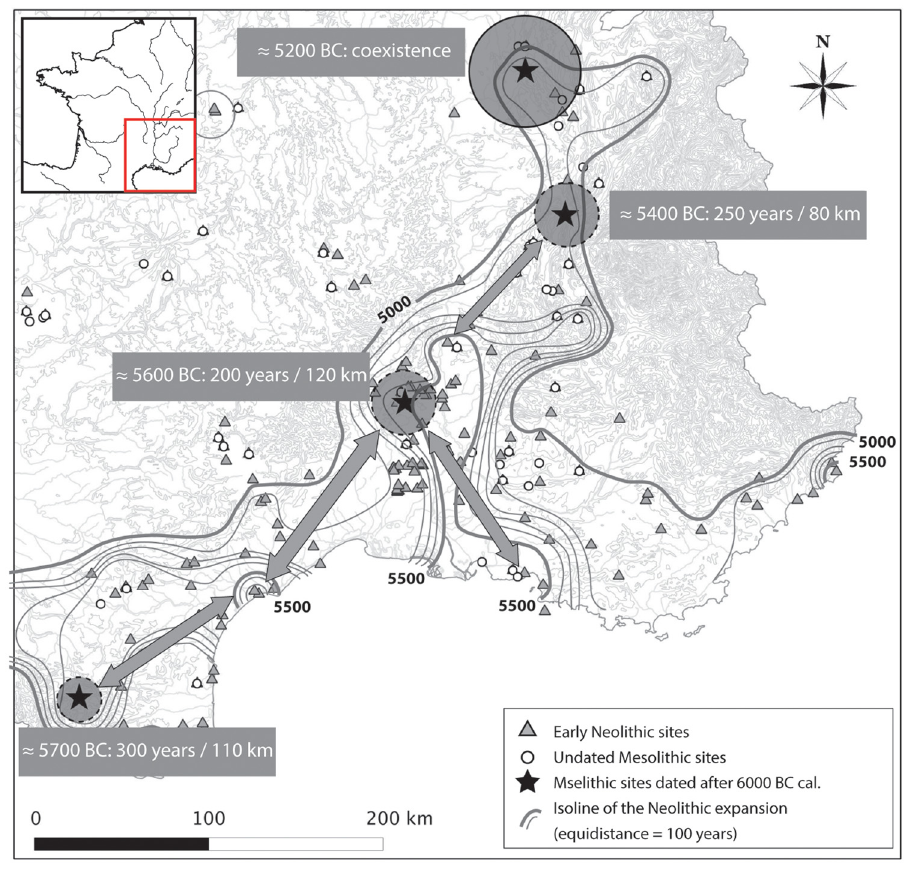
Figure 2: Map of the potentialities of contacts between the last communities of hunters – gathers and the fi rst farmers in southern France ( after Perrin, 2013 )